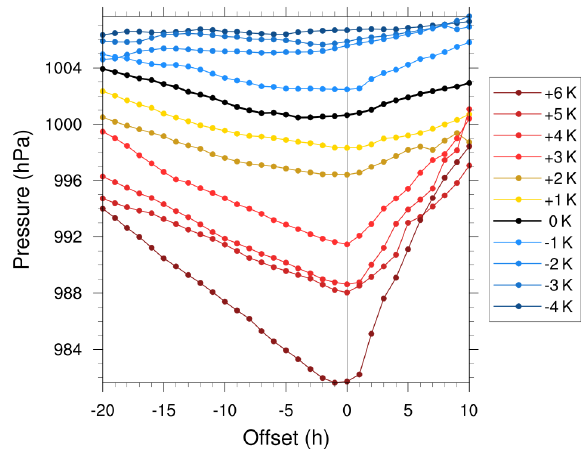
Figure 7. Composite time series of minimum pressure from − 20h before until + 10h after MWCT for each SST